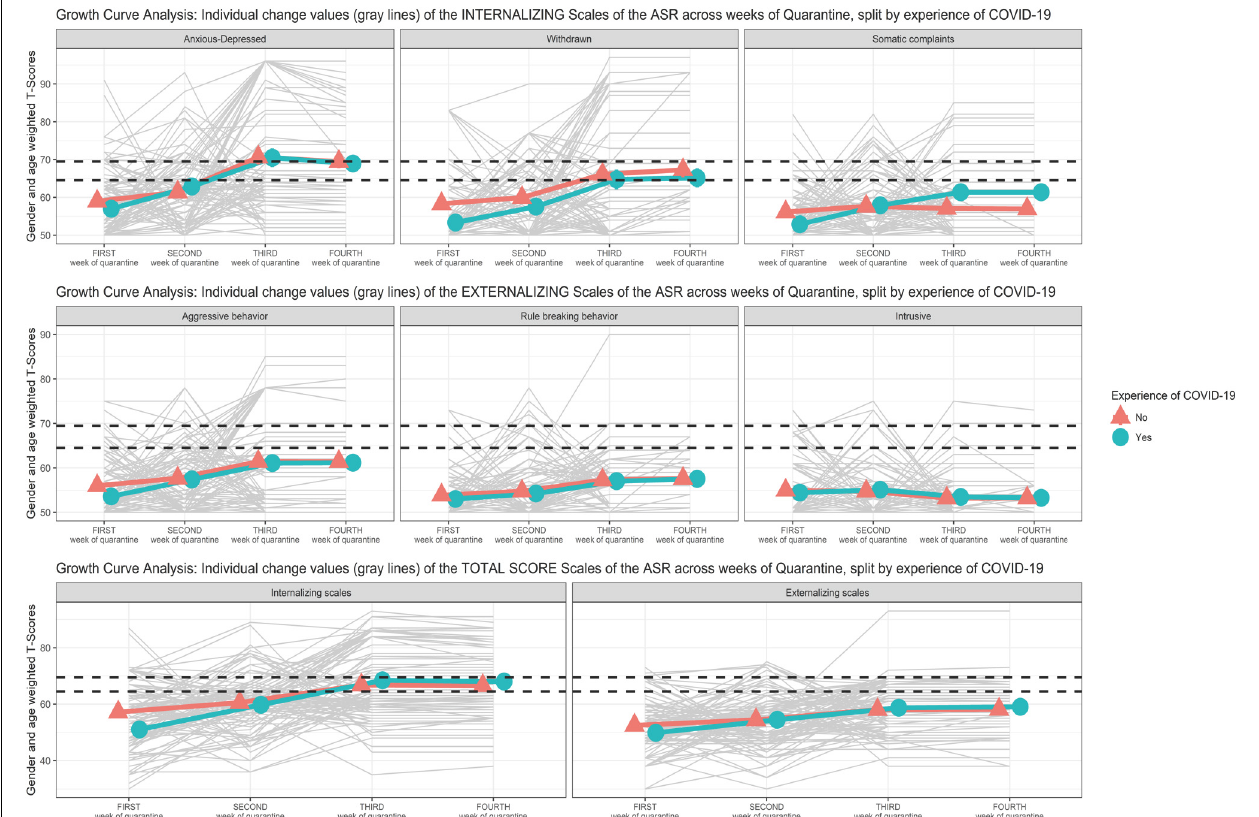
FIGURE 4 | Growth curve analysis (GCA): means and standard error of the Syndromic Scale across weeks of quarantine split by “experience of